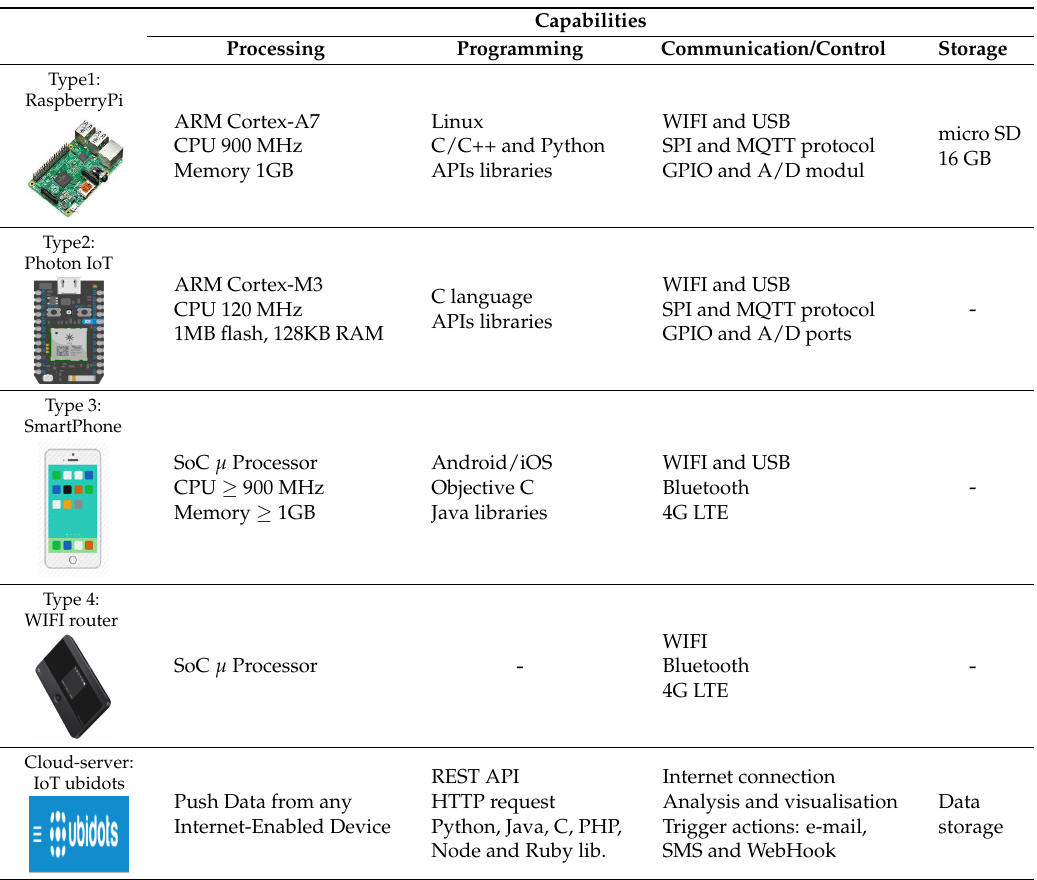
Table 3. Embedded devices used in experimental